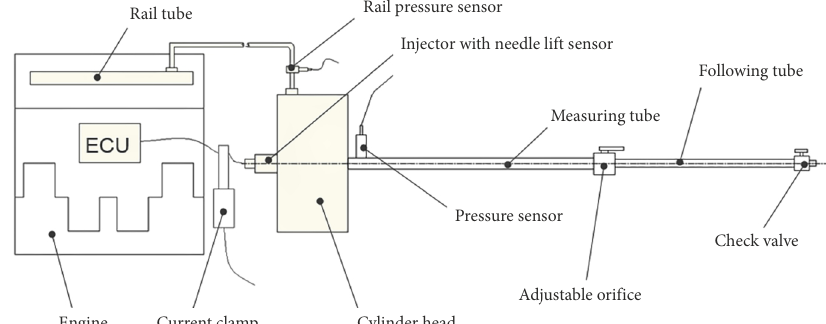
Figure 2. Test bench layout